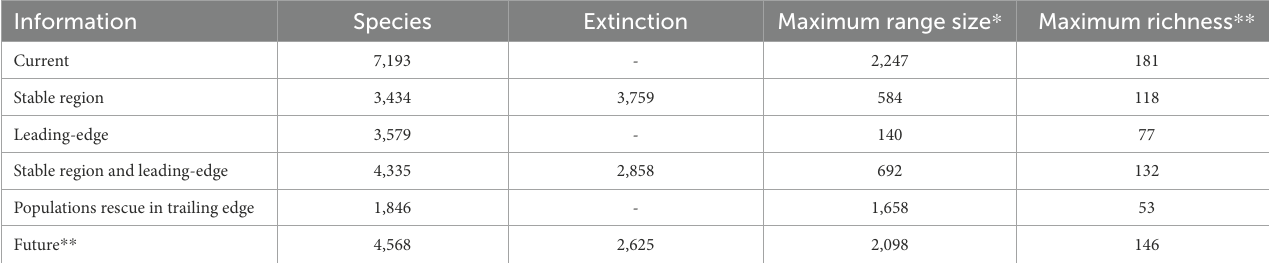
TABLE 2 For amphibian species, range size and richness, in the present, future, and its climatic parts (stable region, leading-edge, and trailing edge). Information